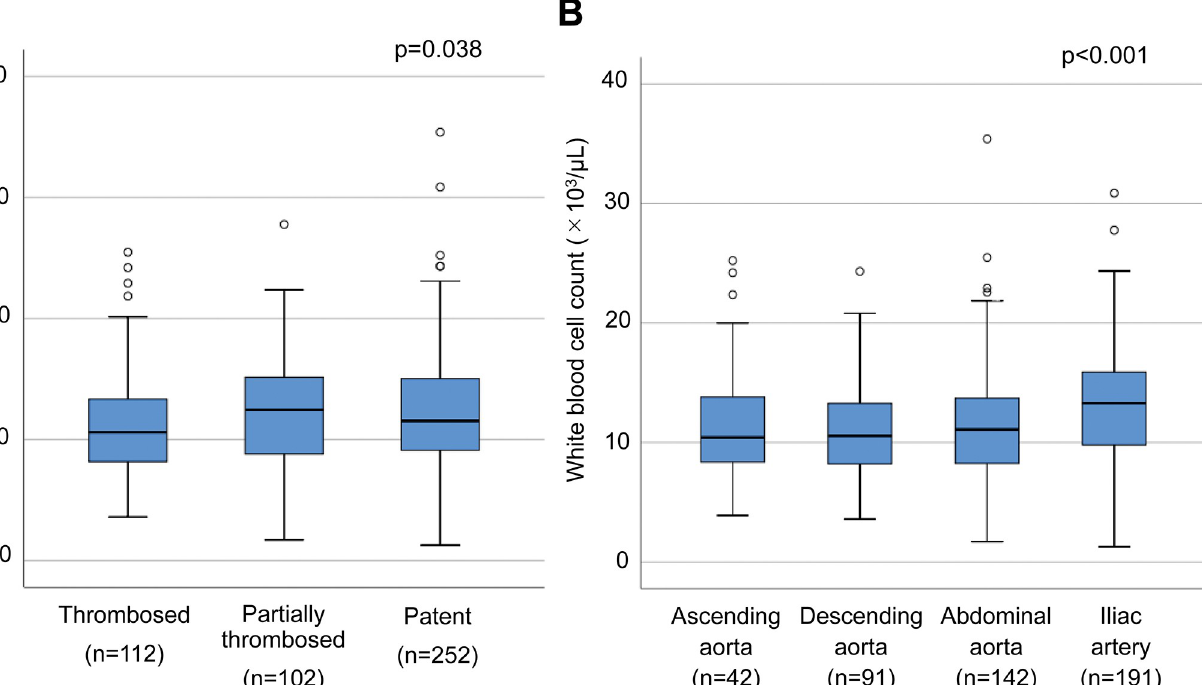
Fig 2. Box and whisker plots of morphologic classifications in relation to white blood cell count. (A) False lumen status. (B) Extent of aortic dissection. Probability values were obtained by Kruskal-Wallis test. https://doi.org/10.1371/journal.pone.0228954.g002 PLOS ONE | https://doi.org/10.1371/journal.pone.0228954 February 6,